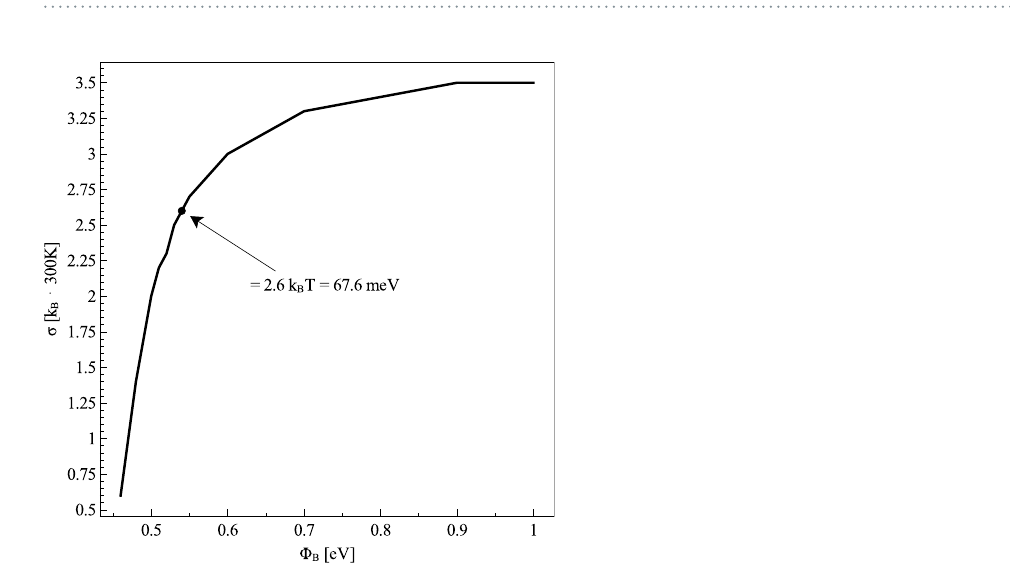
Figure 1. Schematic of the MIS capacitor used for the analysis and related energy levels.